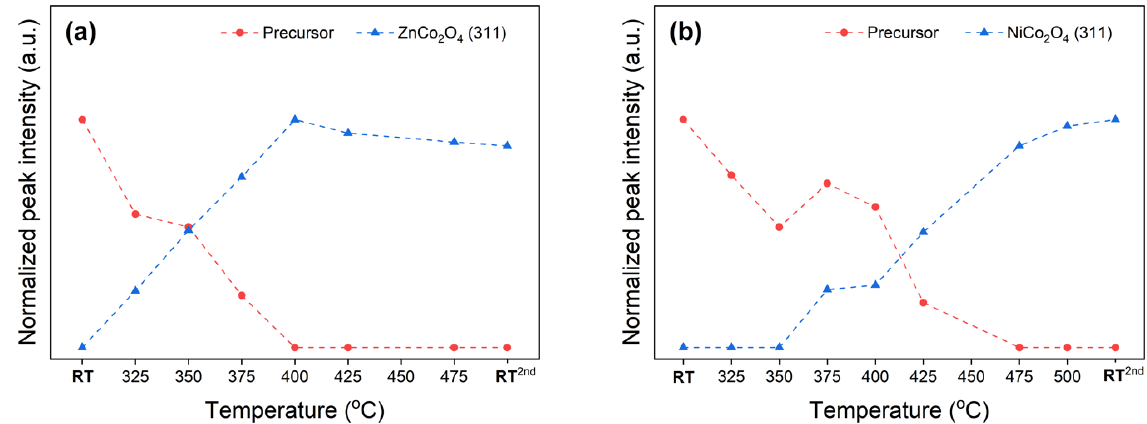
Figure 4. Profiles of normalized XRD intensities represent the progress of phase transformation of ( a ) ZCO and ( b ) NCO precursors, deriving from in-situ XRD data in Figure 3a,b, respectively.